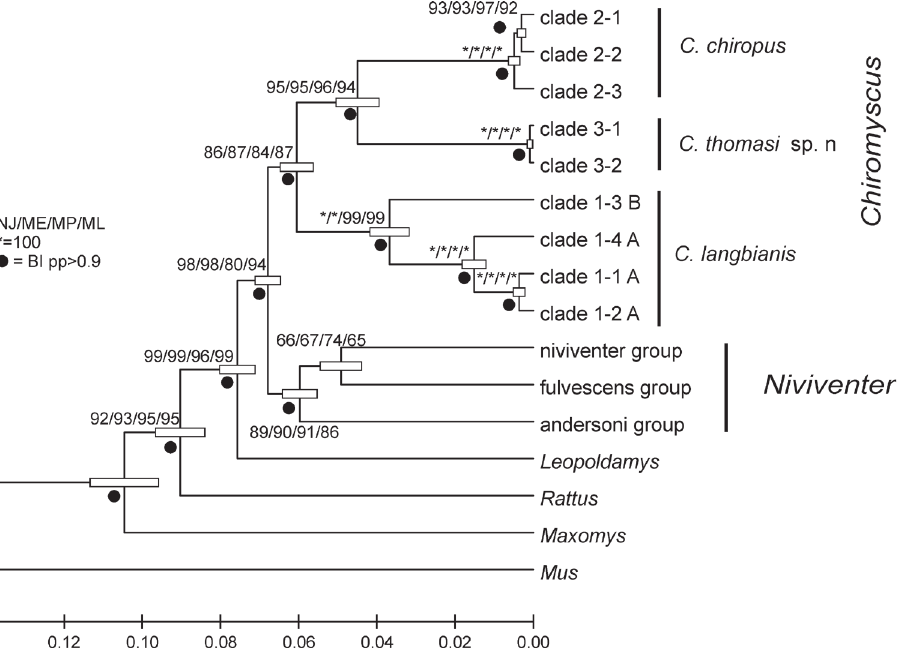
Figure 2. The ultrametric ML phylogenetic tree constructed based on the combined dataset Cytb+COI+IRBP+GHR gene sequences (GTR+G+I; 1-2-3 pos. inc.) of the Niviventer - Chiromyscus com- plex. The bars at the nodes represent the level of confidence of branch